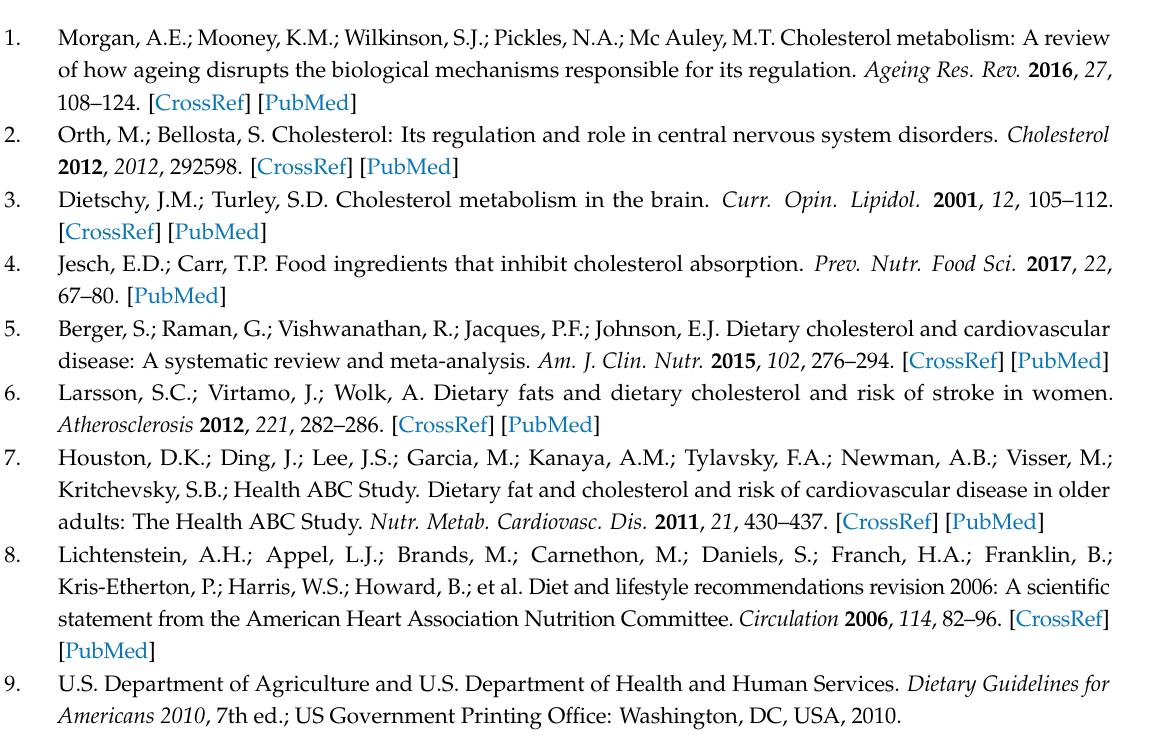
s1, Figure S1: Baseline-corrected total cholesterol (A) and triacylglycerol (B) content in the TRL fraction in study 1, Figure S2: Baseline-corrected total cholesterol (A) and triacylglycerol (B) content in the TRL fraction in study 2, Figure S3: Baseline-corrected total cholesterol (A) and triacylglycerol (B) content in plasma in study 1, Figure S4: Baseline-corrected total cholesterol (A) and triacylglycerol (B) content in plasma in study